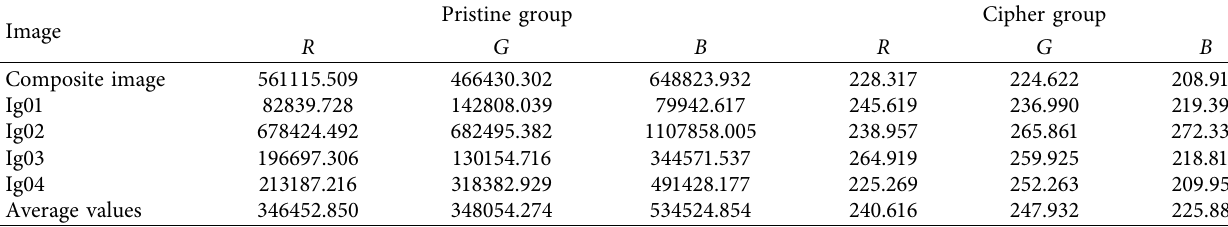
Table 2: Chi-square values for images in the pristine and cipher groups.